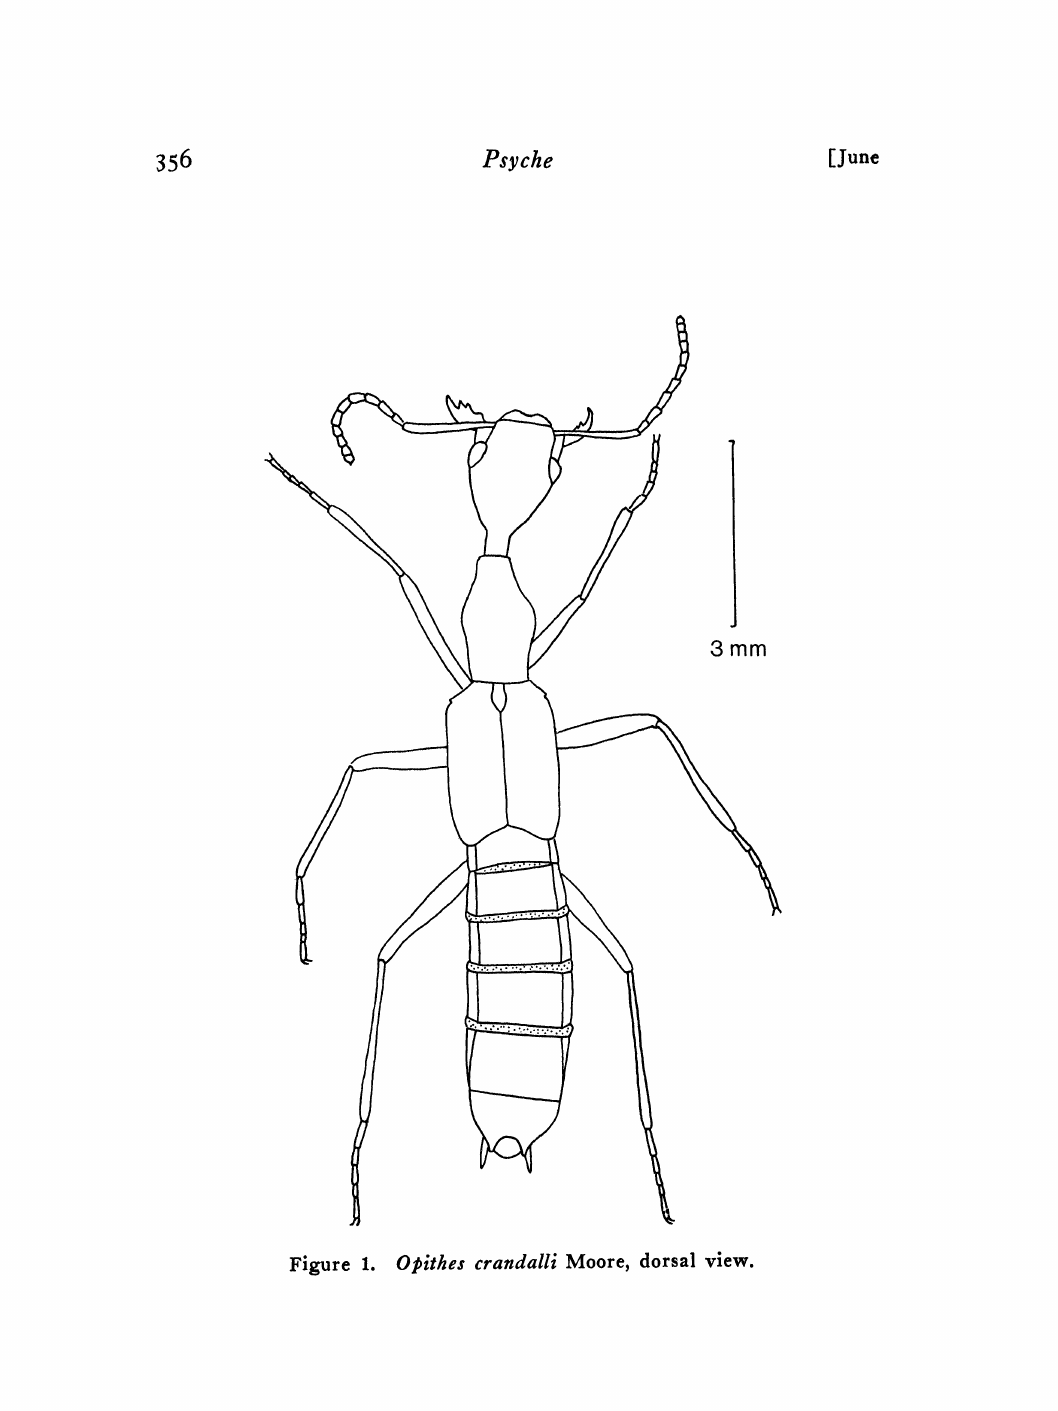
Figure 1. Opithes crandalli Moore, dorsal